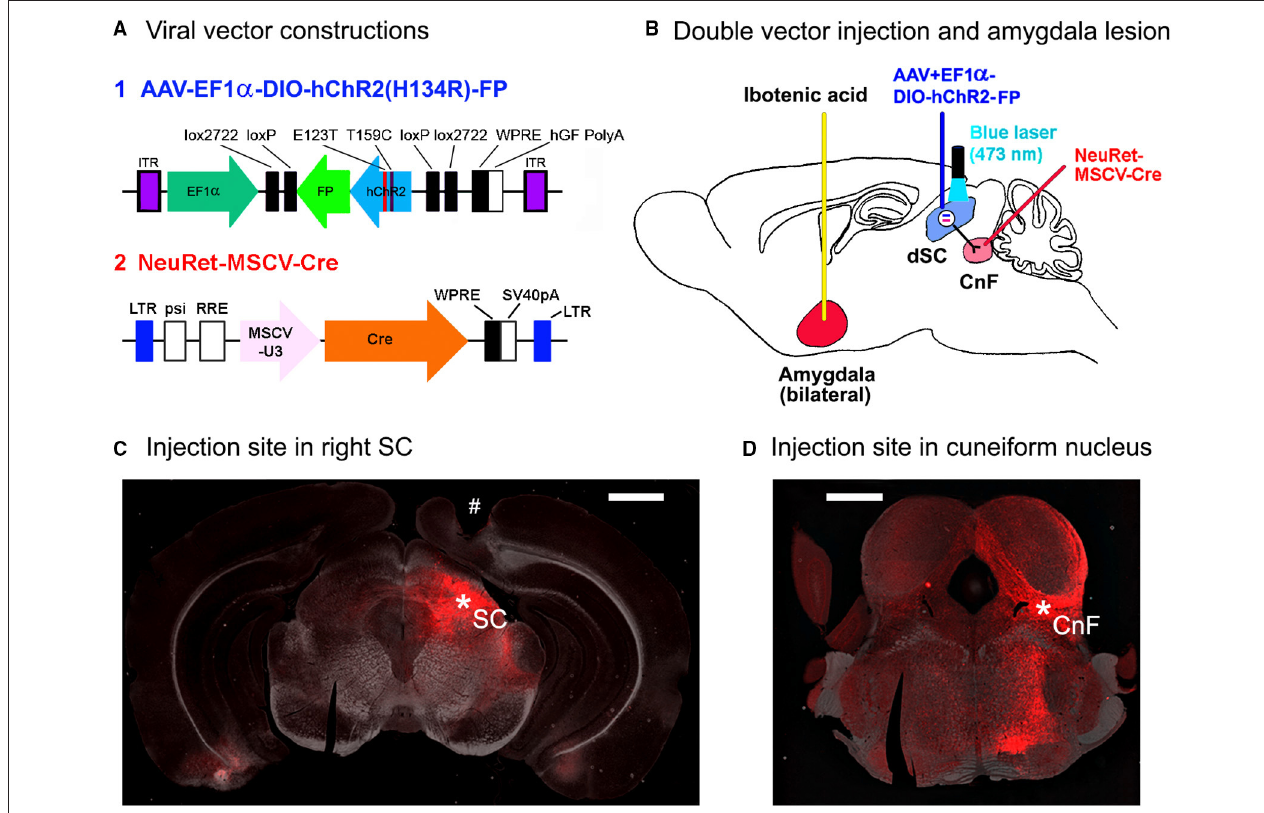
FIGURE 1 | Methods for the optogenetic activation of SC defense pathway in mice. (A) Viral vector constructions. (B) The schematic diagram for the double injection of the viral vectors into the right cuneiform nucleus and the right superior colliculus (SC) and the interaction of NeuRet-MSCV-Cre and AAV-EF1 α -DIO-hChR2(H134R)-FP in the double-infected SC neurons, and bilateral amygdala lesion induced by the ibotenic acid injection. (C) A photomicrograph of the injection site in the right SC ( * SC). # Optic fiber tract for optogenetic stimulation. Scale bar = 1mm. (D) A photomicrograph of the injection site in the right cuneiform nucleus ( * CnF). Scale bar = 1 mm.